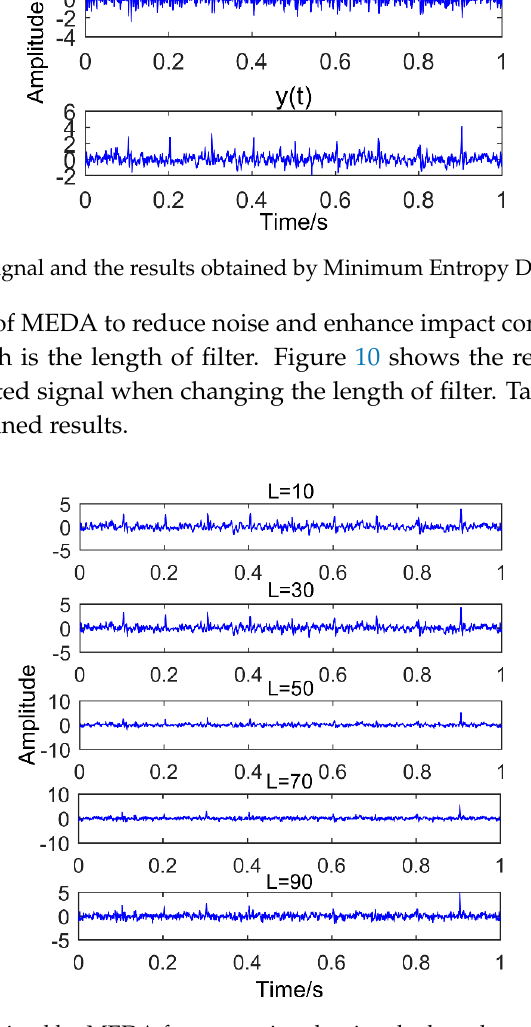
( b ) Frequency domain Figure 8. The results obtained by SSD for processing the synthetic signal when adding noise and impact signals. 4.2. Advantages and Limitations of the Minimum Entropy Deconvolution Adjusted